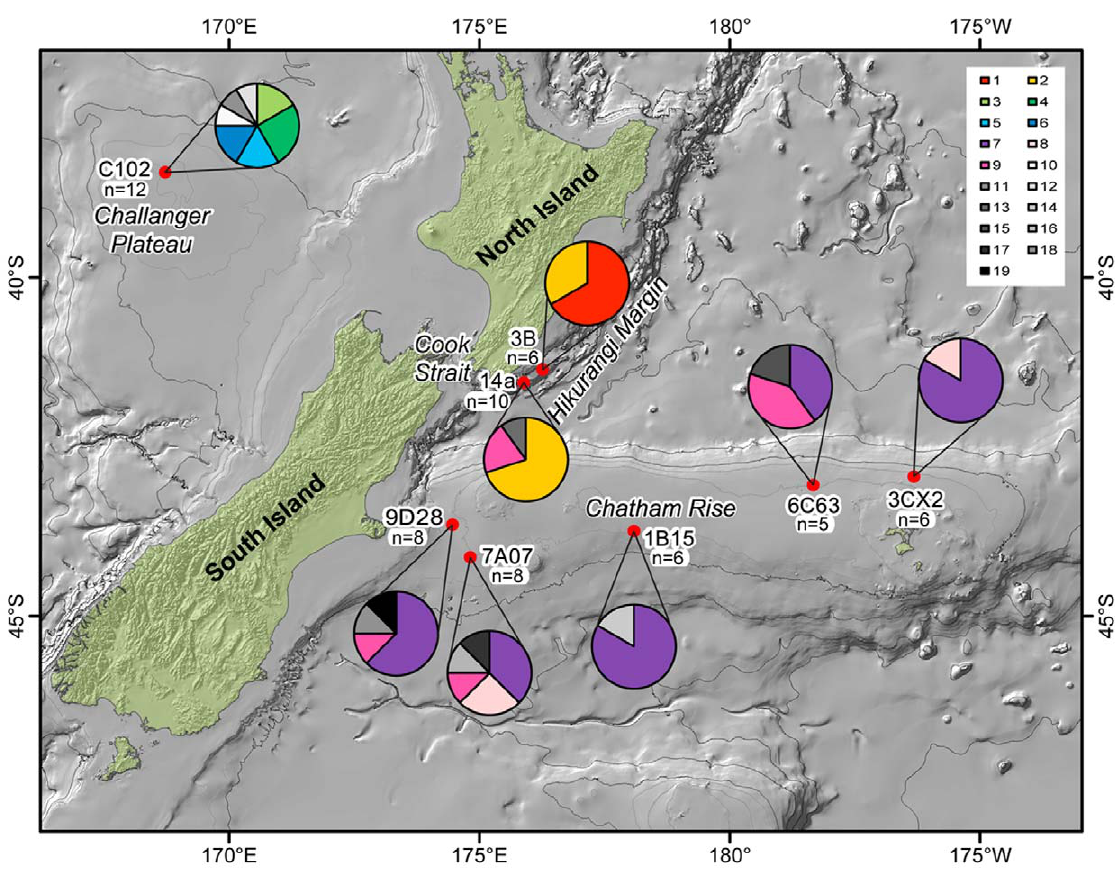
Figure 4. Distribution of 16S haplotypes across the study area for Hyalinoecialongibranchiata . The map shows the location of the study sites with pie charts indicating the haplotype composition of the populations from that site. Each color represents a shared haplotype. White, black, and shades of grey represent unique haplotypes. Sample size for each site is indicated.